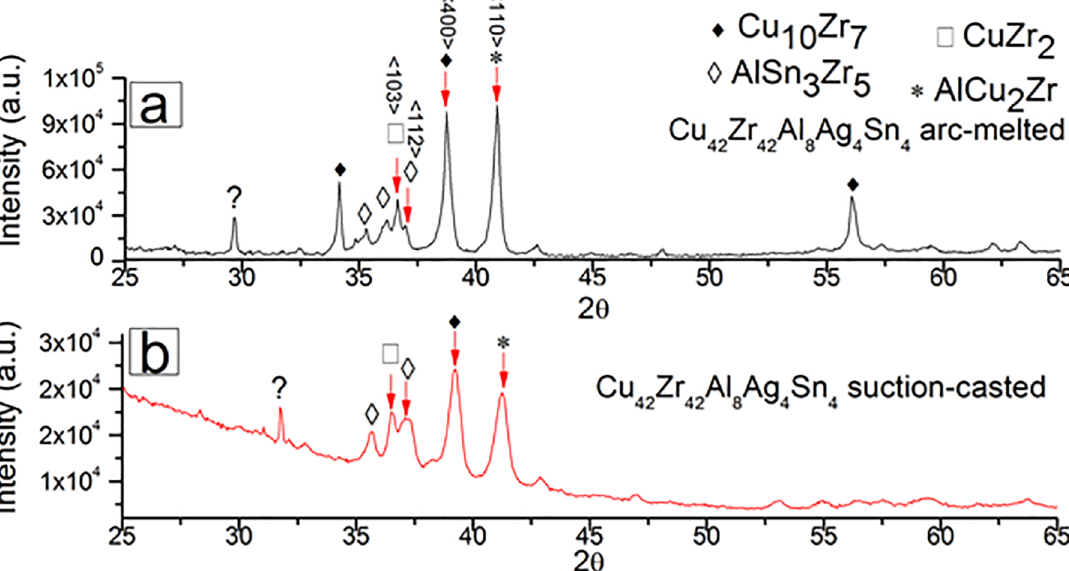
Figure 3. X-ray diffractograms of Cu for crystallite size